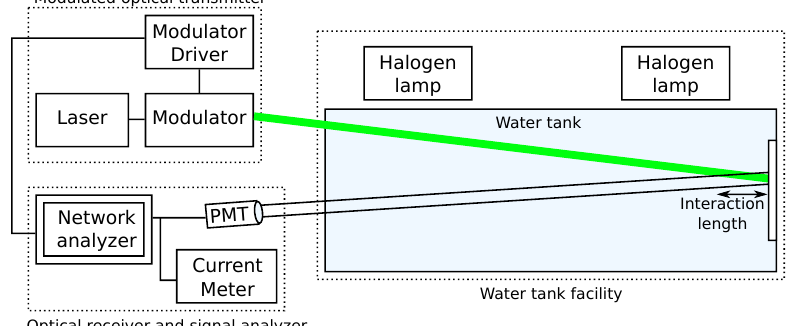
Figure 5. Laser line scanning setup including a modulated optical transmitter, an optical receiver and signal analyzer and a water tank facility. The interaction length is the distance over which the transmitted beam and the receiver field of view overlap. Reproduced from [66].